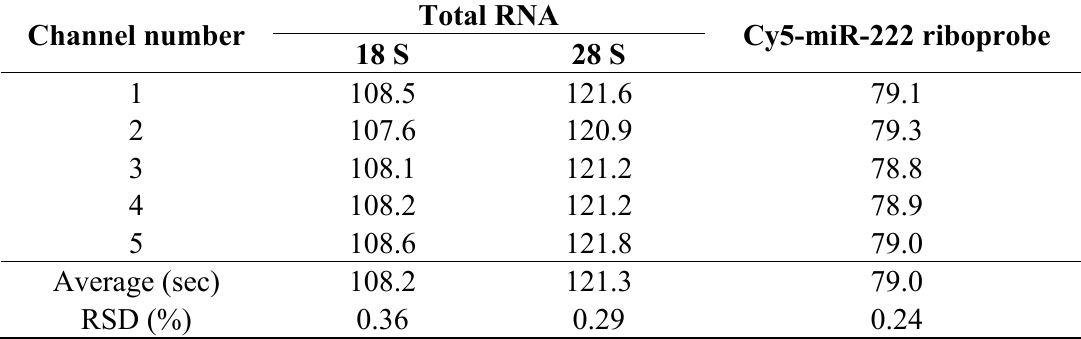
Table 2. Reproducibility of migration times of 18S ribosomal RNA, 28S ribosomal RNA, and Cy5-labeled miR-222